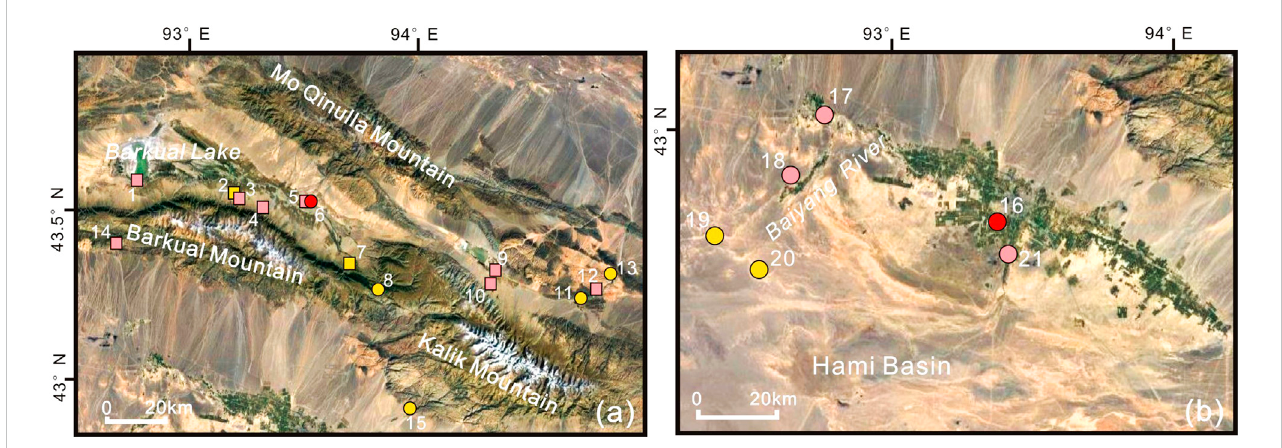
FIGURE 6 Topographic map of Eastern Tianshan Mountains and the sites mentioned in this study. (A) Areas on both sides of the Eastern Tianshan Mountains. 1. Haiziyan; 2. Xigou; 3. Dongheigou (Shirenzigou); 4. Hongshankou; 5. Qinggeda; 6. Nanwan; 7. Heigouliang; 8. Hanqigou; 9. Yanchi Gucheng; 10. Kuola; 11. Tuobeilang; 12. Baiqier 13. Xiagou; 14. Liushugou; 15. Huangtianshangmiaoergou I plot. (B) Hami Basin. 16. Tianshanbeilu; 17. Yanbulake; 18. Wupu; 19. Aisikexiaer; 20. South Aisikexiaer; 21.